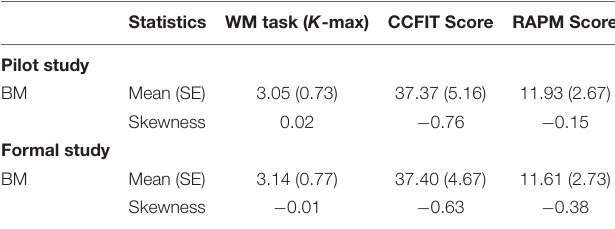
TABLE 1 | Mean value (SE) and results of skewness test of each measured variable in the current